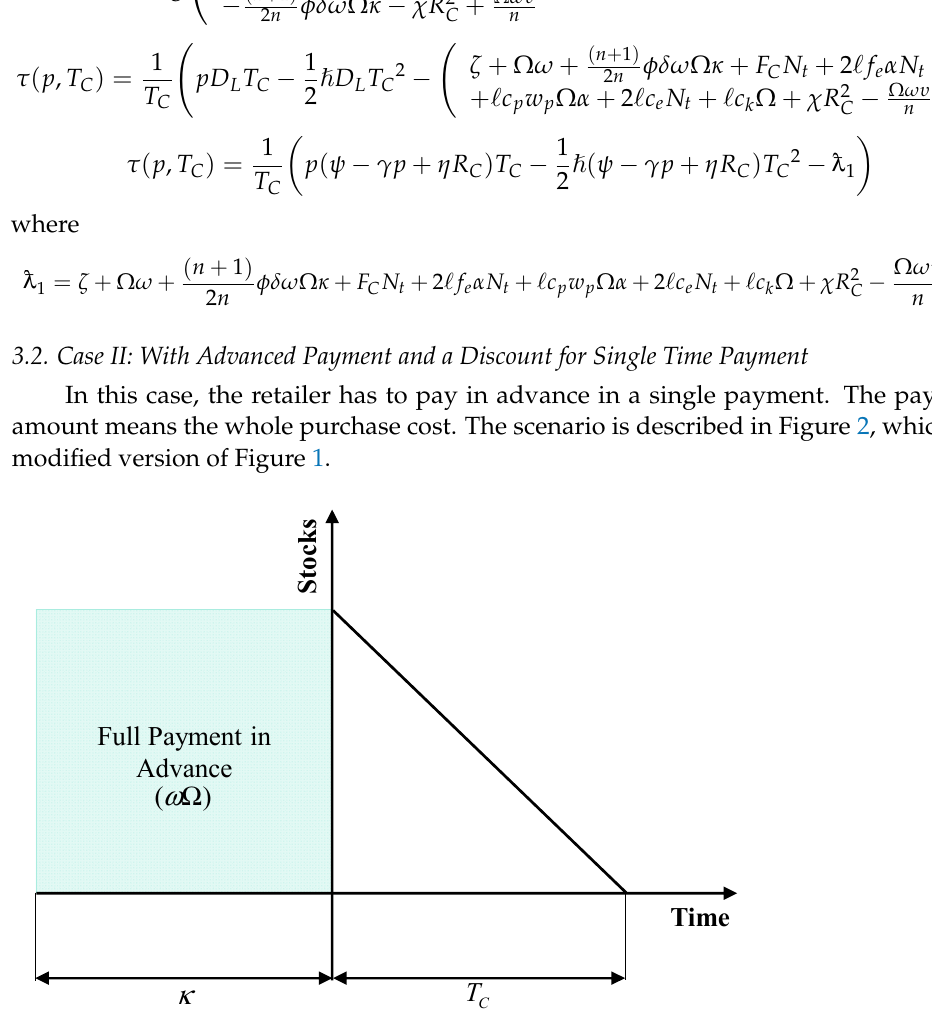
Figure 2. Graphical presentation of the inventory system for Case II.